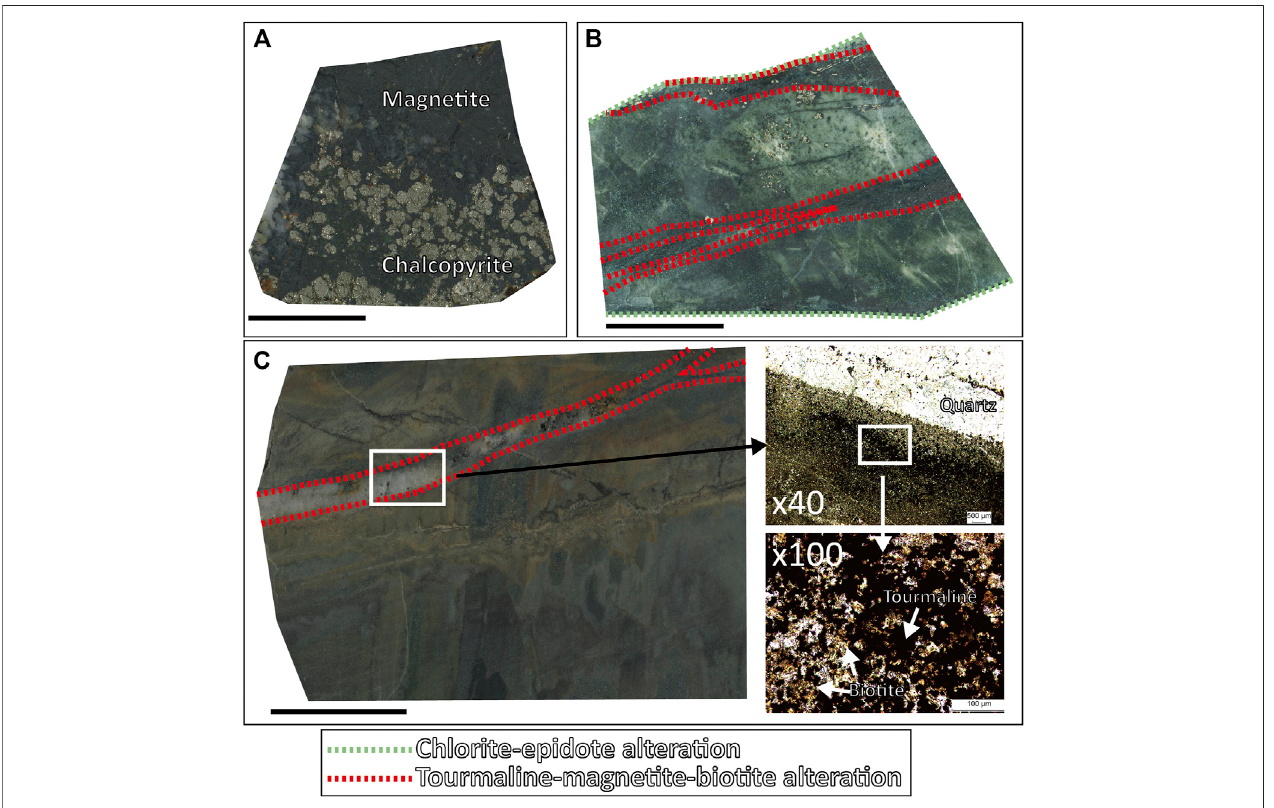
FIGURE 4 | Vein and alterations petrography of the Gunbuk deposit. (A) Massive magnetite and chalcopyrite occur in quartz veins with tourmaline alteration. (B) The chlorite-epidote altered host rock is crosscut by quartz veins with the tourmaline-magnetite alteration. (C) The quartz vein with the tourmaline-biotite alteration. Tourmaline and biotite were con fi rmed by microscopy. The green dotted lines represent a chlorite-epidote “ CE ” alteration, and the red dotted lines represent a tourmaline-(magnetite)-biotite “ TB ” alteration.